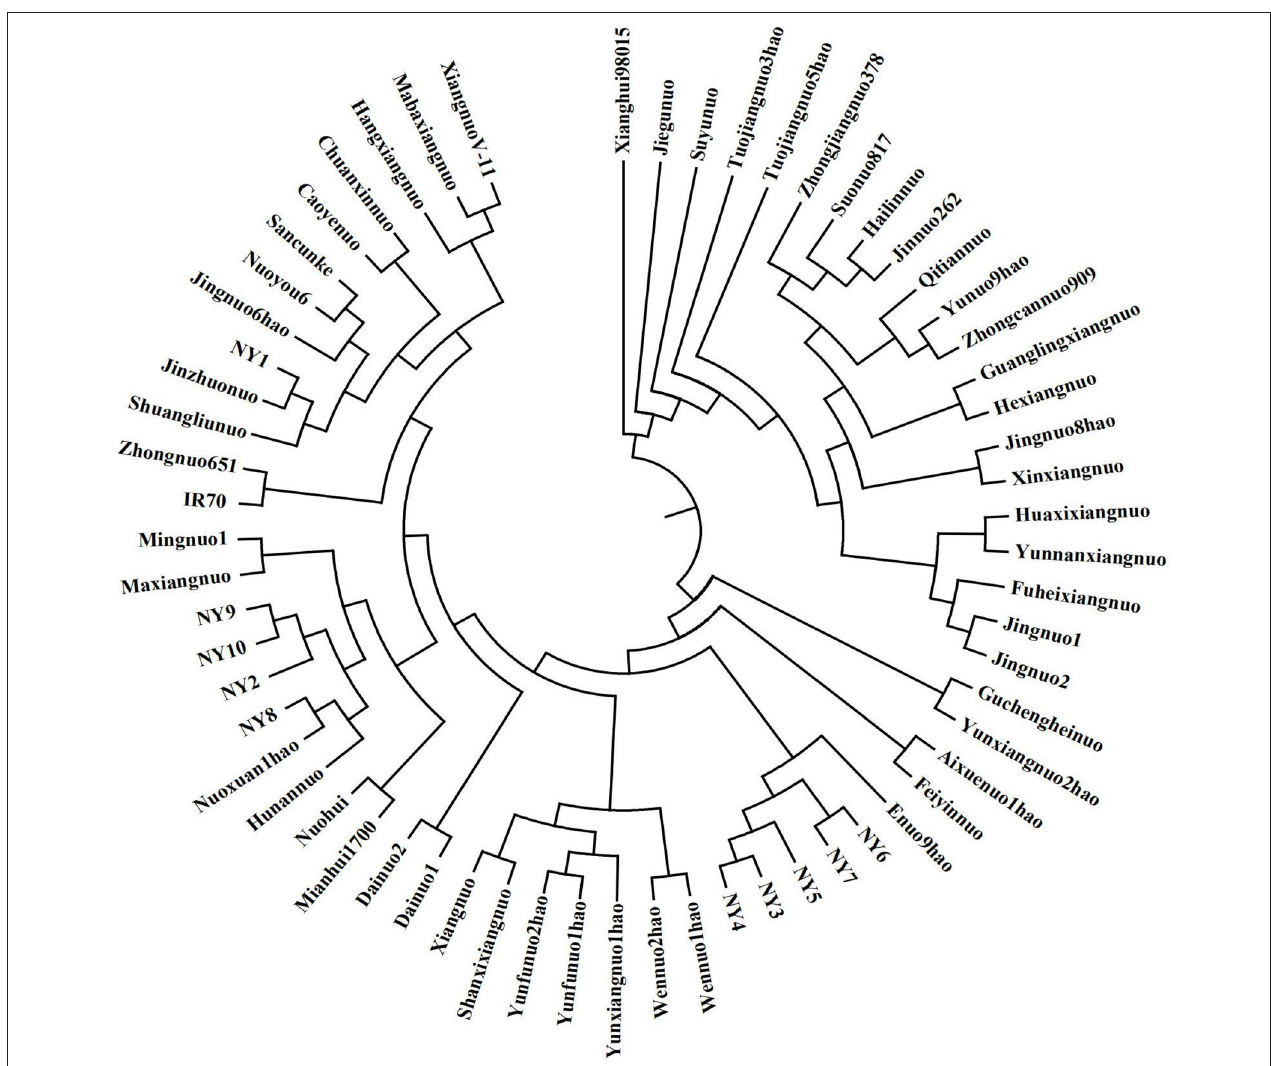
FIGURE 2 | A dendrogram of rice landraces based on Nei’s genetic